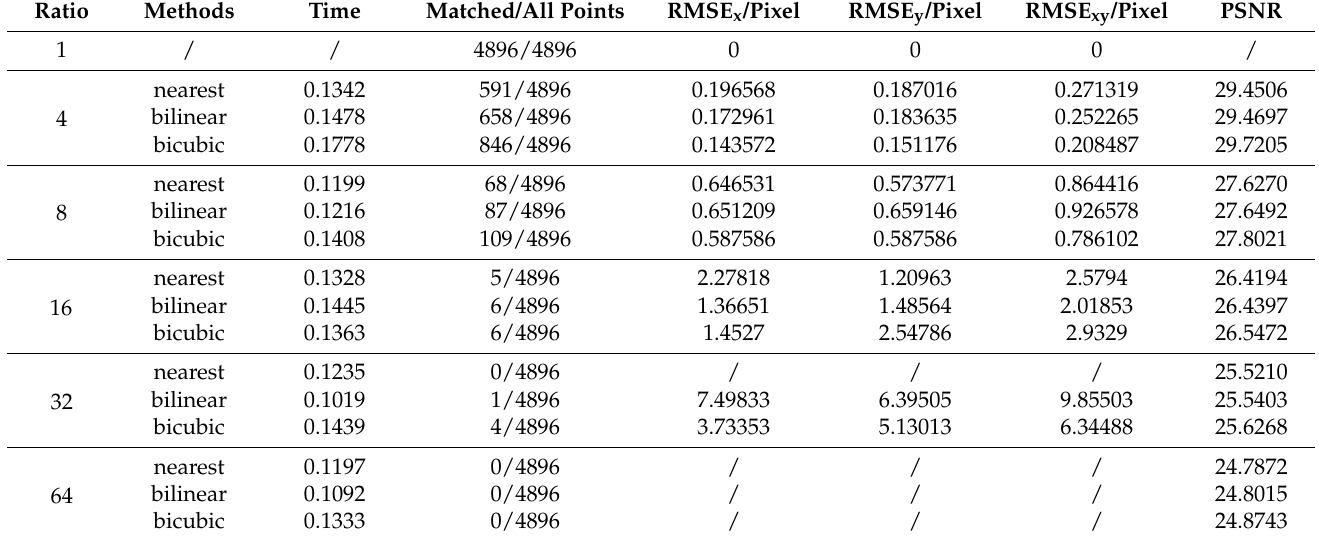
Table 6. The impacts of the resample